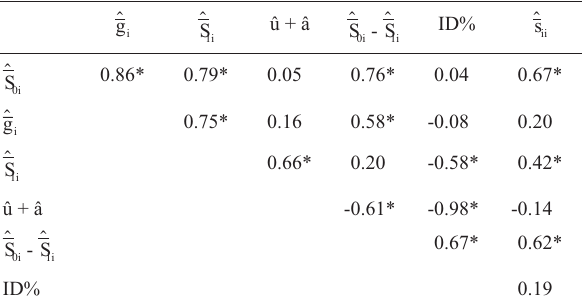
Table IV - Pearson’s correlation coefficients among the estimates of seven parameters obtained from the diallel and the inbreeding depression analysis for ear weight (kg/ha) of 28 maize populations assessed in 10